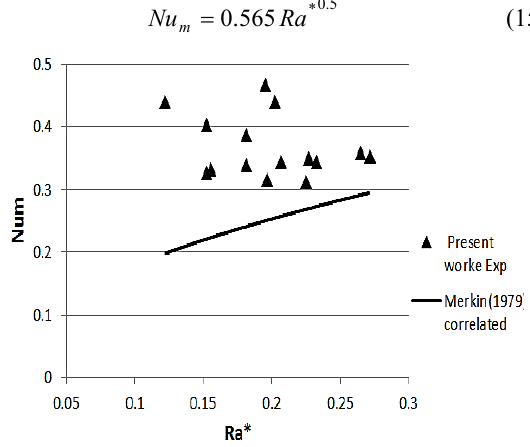
Figure 6.Average face temperature with different voltages at a depth/radius ratio of 16.5.